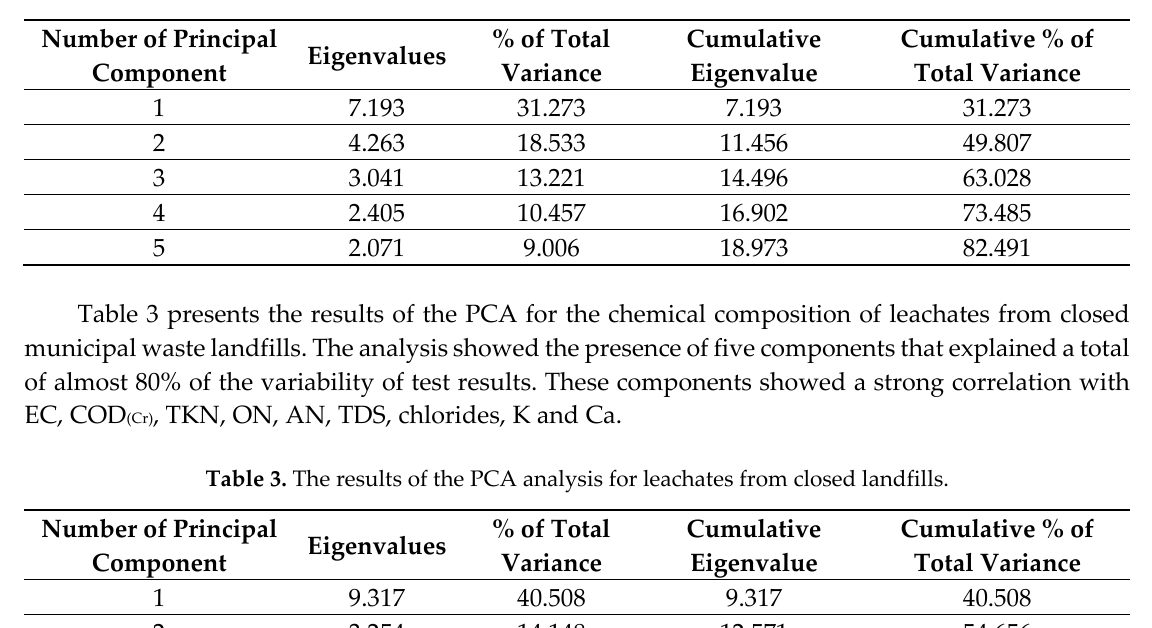
Table 2. The results of the principal component analysis (PCA) analysis for leachates from operational landfills.